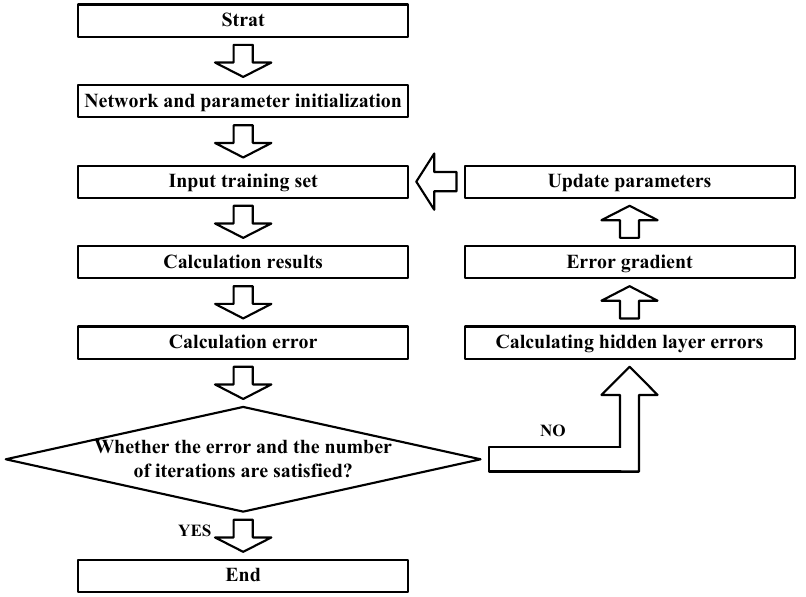
Figure 1. The calculation flow-chart of the BP neural network (BPNN).